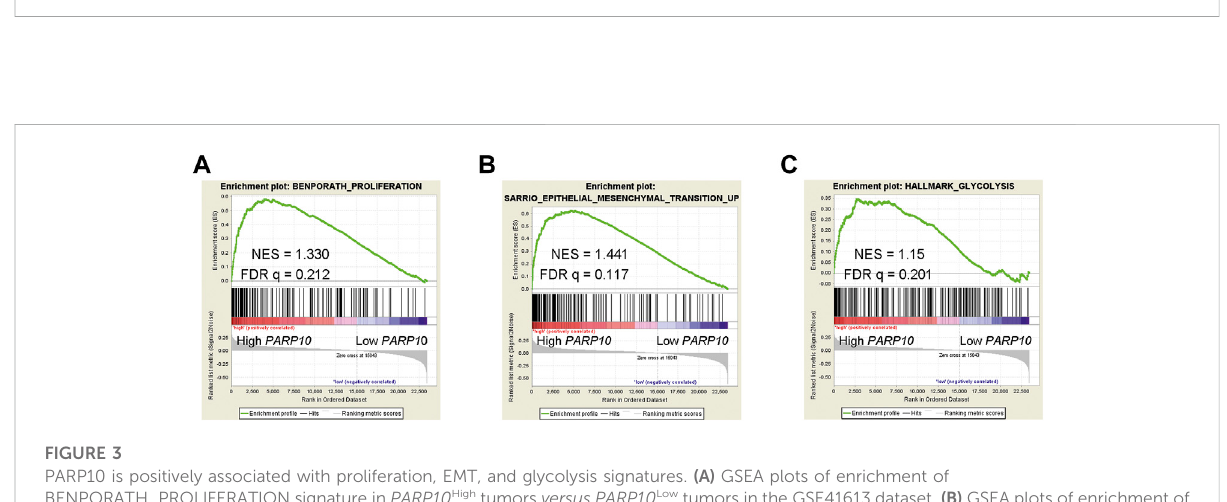
FIGURE 3 PARP10 is positively associated with proliferation, EMT, and glycolysis signatures. (A) GSEA plots of enrichment of BENPORATH_PROLIFERATION signature in PARP10 High tumors versus PARP10 Low tumors in the GSE41613 dataset. (B) GSEA plots of enrichment of SARRIO_EPITHELIAL_MESENCHYMAL_TRANSITION_UP signature in PARP10 High tumors versus PARP10 Low tumors in the GSE41613 dataset. (C) GSEA plots of enrichment of HALLMARK_GLYCOLYSIS signature in PARP10 High tumors versus PARP10 Low tumors in the GSE41613